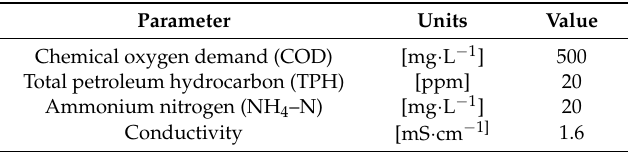
Table 1. Average characteristics of the feeding wastewater.